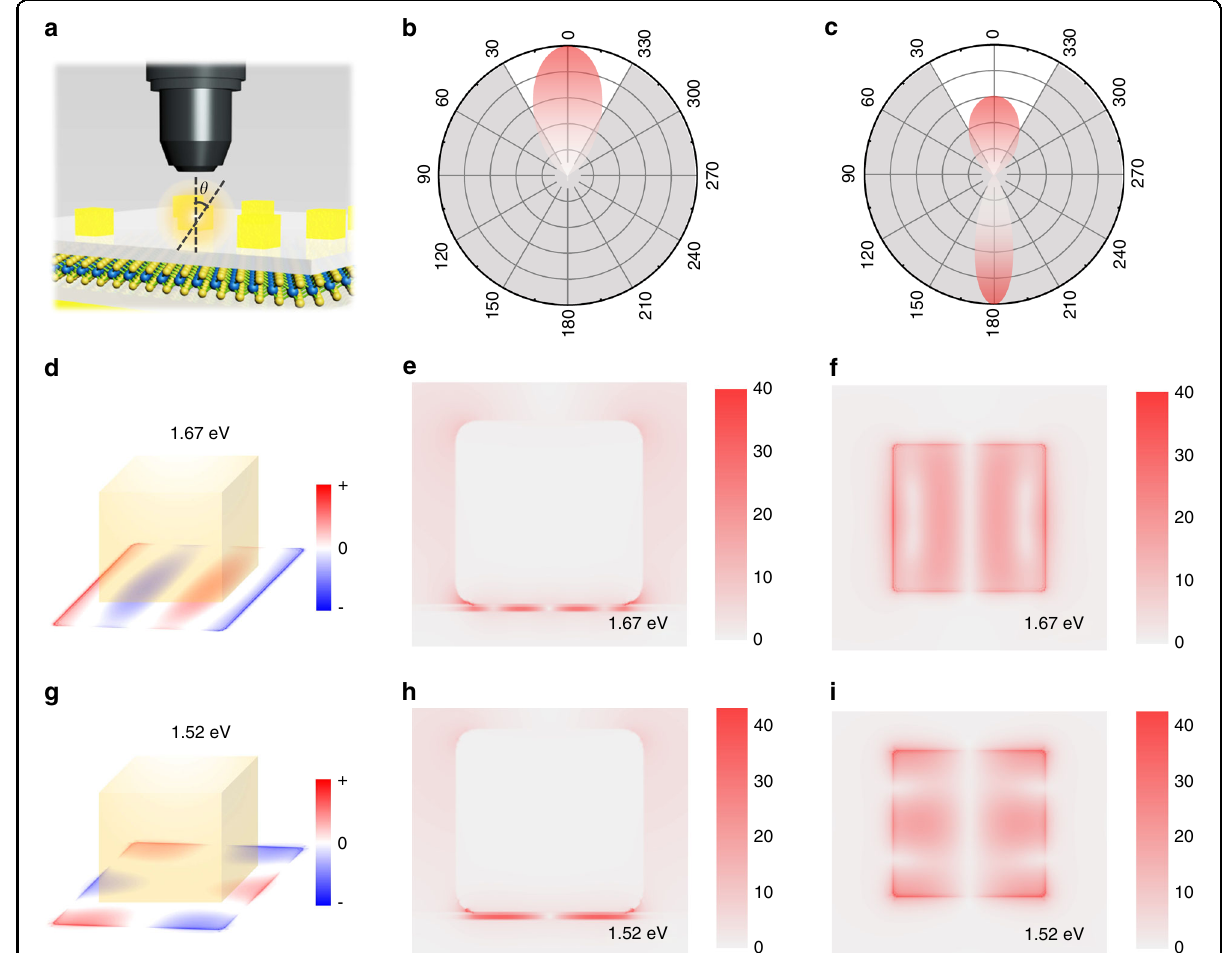
Fig. 4 Mechanism of the enhanced upconversion of the plasmonic cavity. a Schematic of the setup for collecting upconverted emissions in our experiments. b , c Far- fi eld angular radiation patterns for monolayer WSe 2 in the plasmonic cavity ( b ) and free space ( c ). d – f Charge and fi eld distribution (|E/E 0 |) around the plasmonic cavity for the mode at the emitted photon energy (1.67 eV). g – i Charge and fi eld distribution (|E/E 0 |) around the plasmonic cavity for the mode at the excitation photon energy (1.52